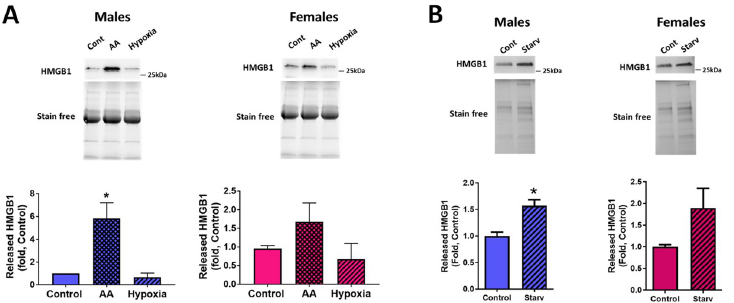
Fig 7. Sex difference in HMGB1 release in stressed MLEC and HPAEC. HMGB1 released into conditioned media was measured by WB analysis. A –HMGB1 signal in male and female MLEC exposed to hypoxia or AA as described above. B –HMGB1 in media collected from Control and starved male and female HPAEC. Values are means ± SEM. N = 4 repetitions for MLEC (5–7 mice isolated for each sex). � p < 0.05 versus Control MLEC. Statistical analysis was performed using one way ANOVA (Turkey’s multiple comparisons test). N = 6 repetitions for HPAEC. � p < 0.05 versus Control HPAEC. Statistical analysis was performed using the unpaired t-test.